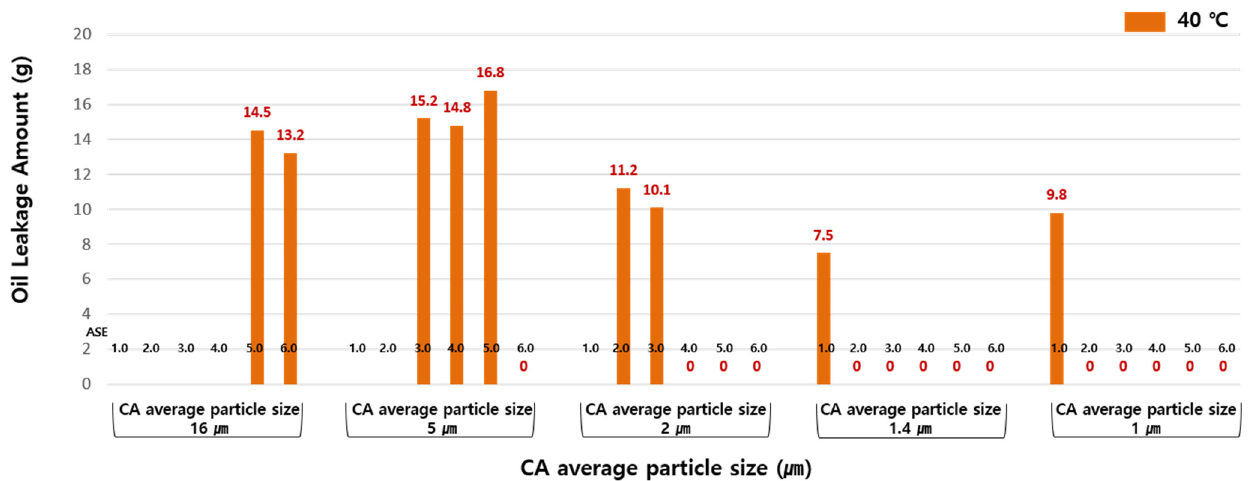
Figure 10. Graph of oil leakage stability test results (40 °C).